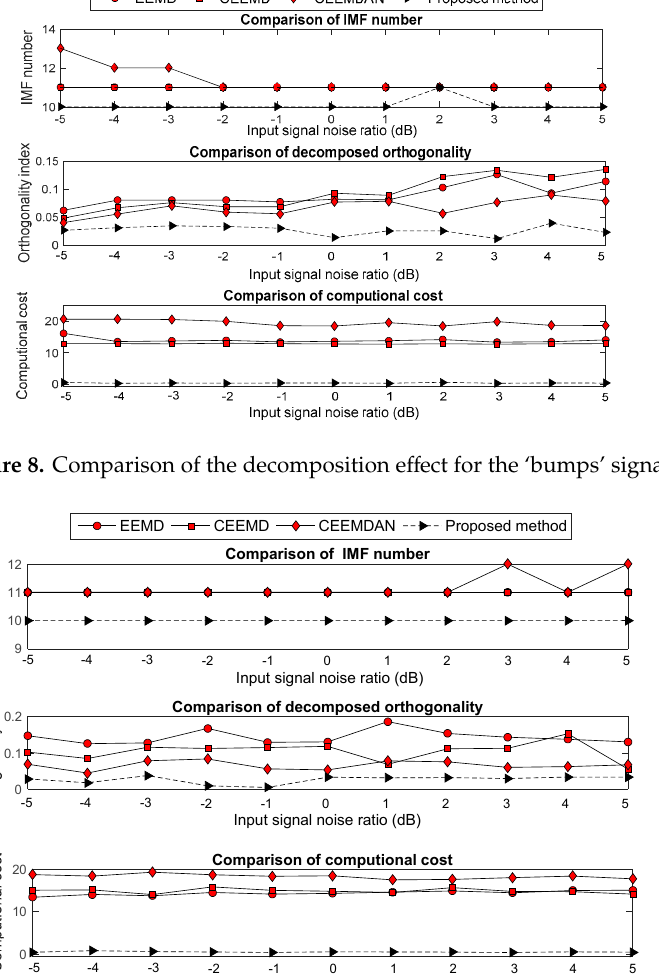
ff ect for the ‘heavy sine wave’ signal. Sensors 2019 , 19 , x FOR PEER REVIEW